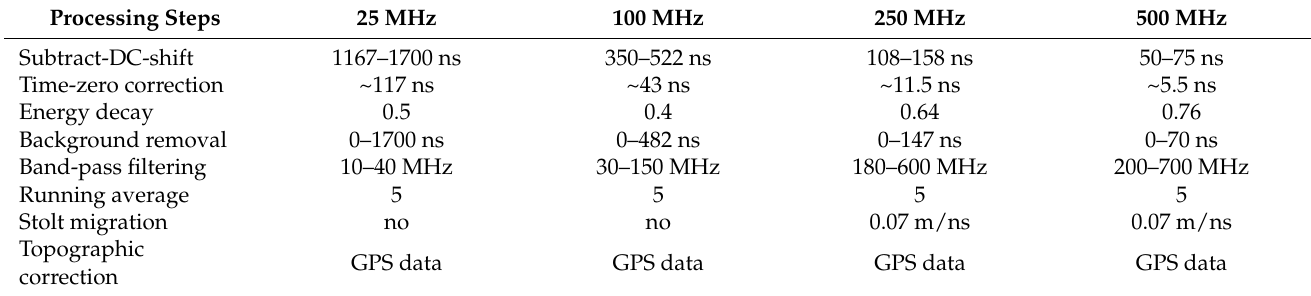
Table 2. GPR data processing steps.